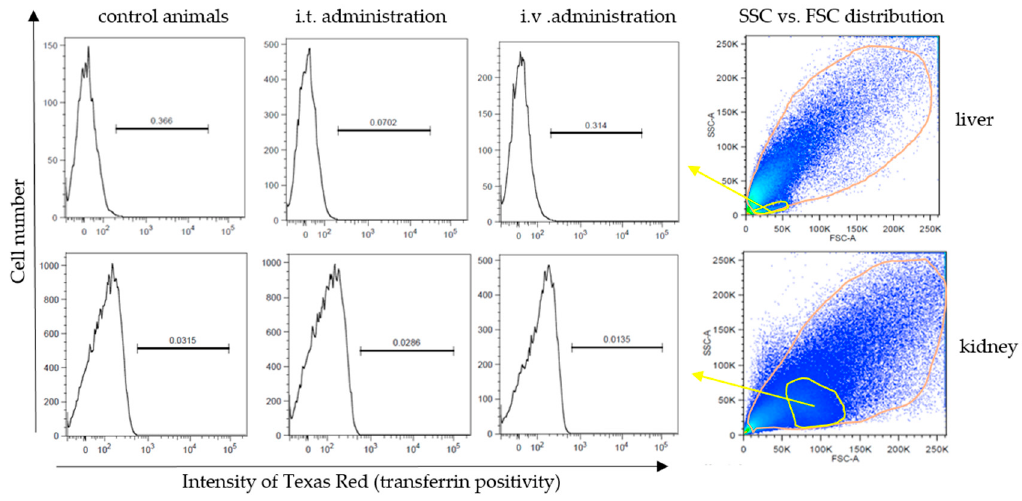
Figure A2. Texas Red signal in leukocytes obtained from homogenized liver and kidney after NDA135b administration.